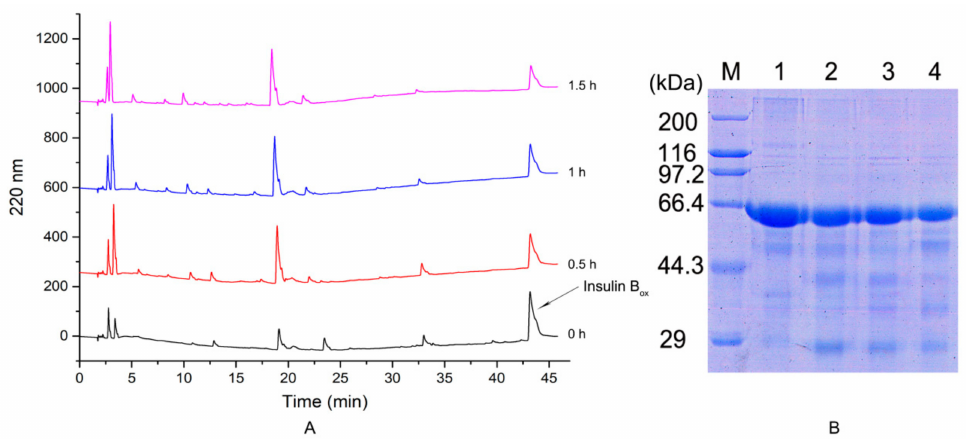
Figure 5. Hydrolysis of bovine serum albumin (BSA) and insulin B ox by EH2. ( A ). Analysis of the hydrolysate of insulin Box by reversed-phase high-performance liquid chromatography. ( B ). Analysi of the hydrolysate of BSA by SDS-PAGE. Line marked 1–20 µ L of BSA with 1 µ L of EH2, as a control group; line marked 2–20 µ L of BSA was incubated with 1 µ L of EH2 for 10 min at 50 ◦ C; line marked 3–20 µ L of BSA was incubated with 1 µ L for enzyme solution for 20 min at 50 ◦ C; line marked 4–20 µ L of BSA was incubated with 1 µ L of enzyme solution for 40 min at 50 ◦ C.